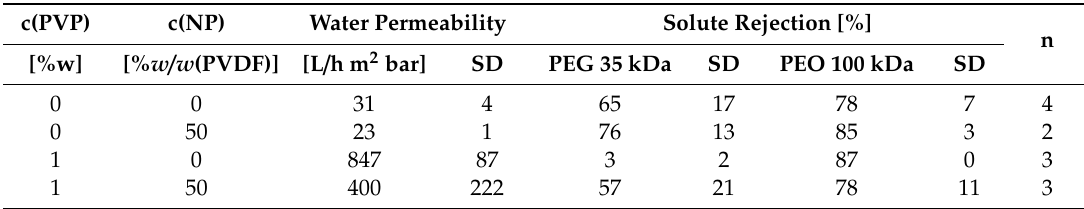
Table 2. Ultrafiltration performance of PVDF membranes prepared with and without PVP as well as with and without ZnO nanofiller in the dope